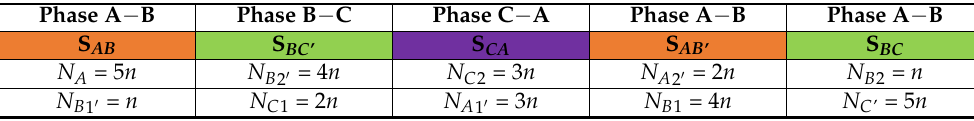
Table 8. Coil turn allocation of common slots for UOSW type B